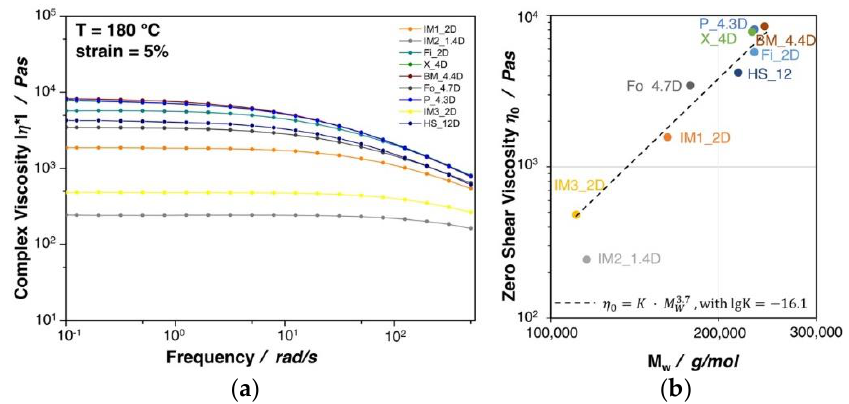
Figure 4. ( a ) Complex viscosity of neat PLA grades at 5% strain and 180 °C. ( b ) Zero shear viscosity plotted against the molecular weight.